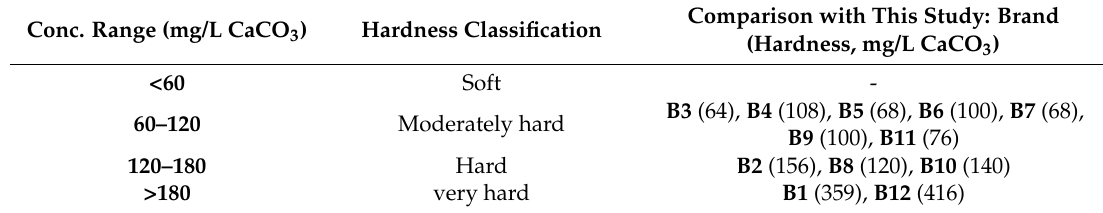
Table 2. Classification of the water hardness compared to the current study